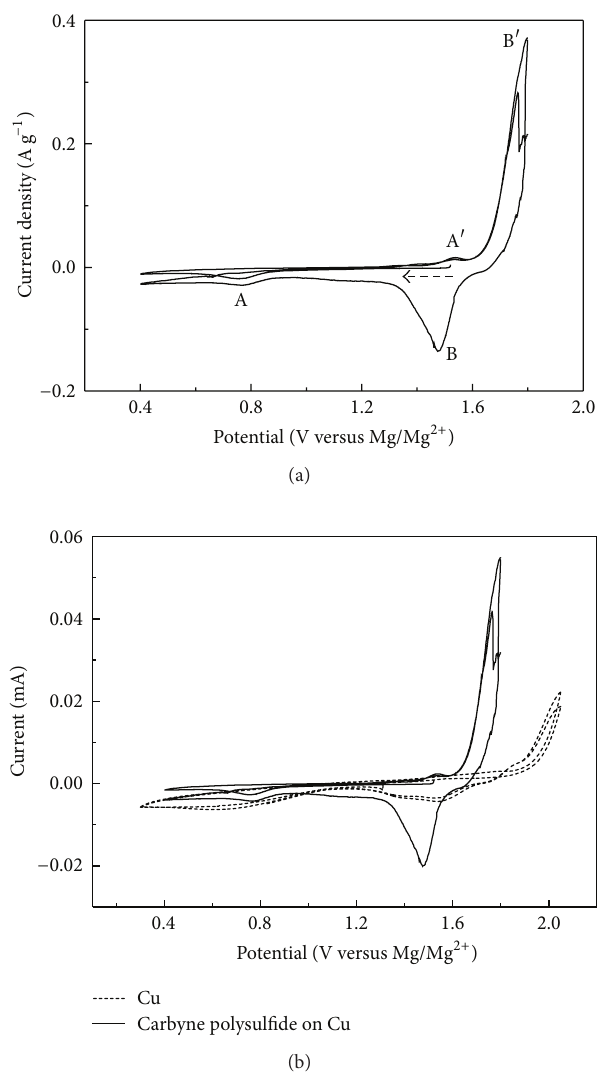
Figure 8: (a) Cyclic voltammograms of carbyne polysulfide in a three-electrode cell employing magnesium metal as the counter electrode and the reference electrode measured at a scan rate of 0.05 mVs −1 . (b) CV comparisons using Cu copper collector and carbyne polysulfide on copper collector as positive electrodes. The active mass of carbyne polysulfide was 0.1476 mg.